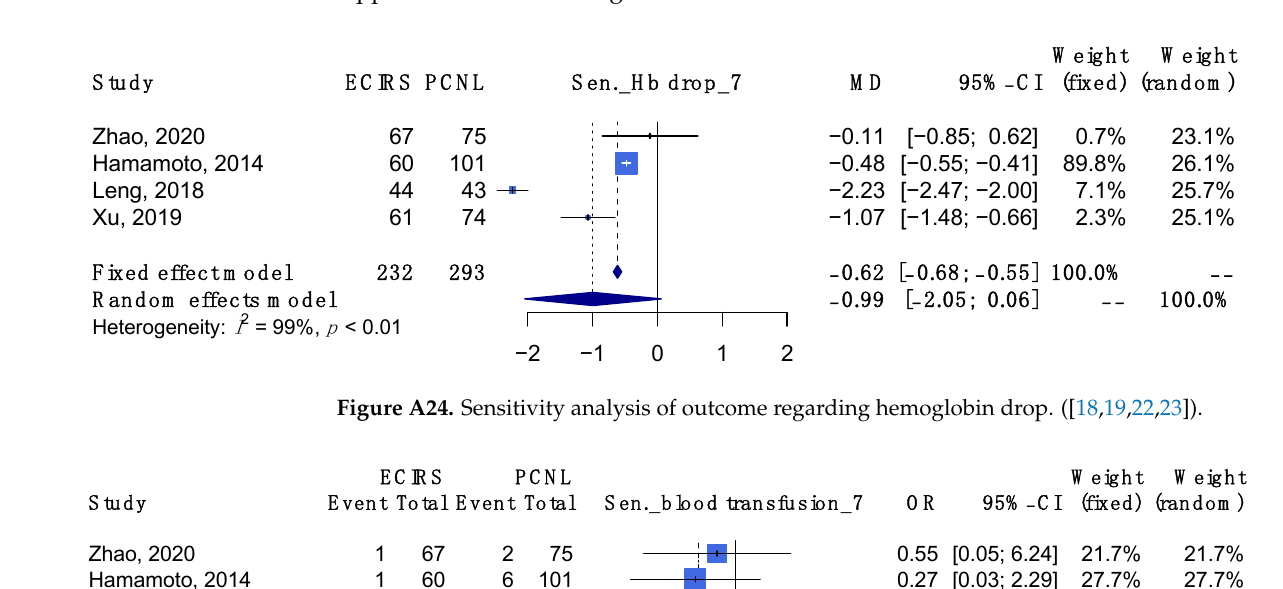
Figure A23. Sensitivity analysis of outcome regarding post-operative fever. ([17–19,22,23])